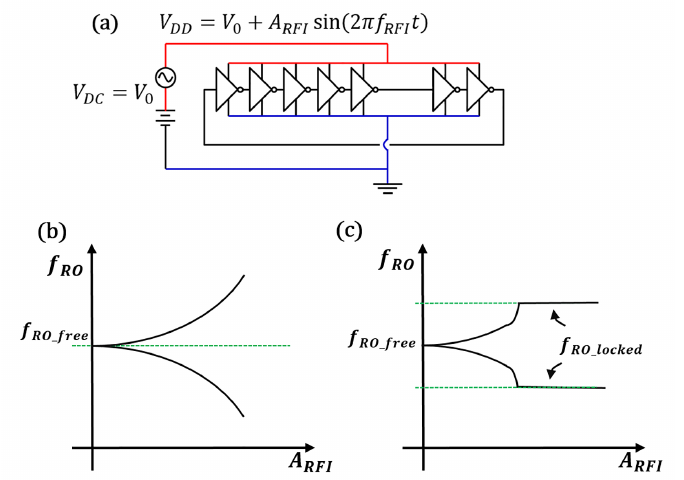
Figure 2. Interference scene and response. ( a ) Interference injection from the power supply; ( b ) injection-pulling phenomenon; ( c ) injection-locking